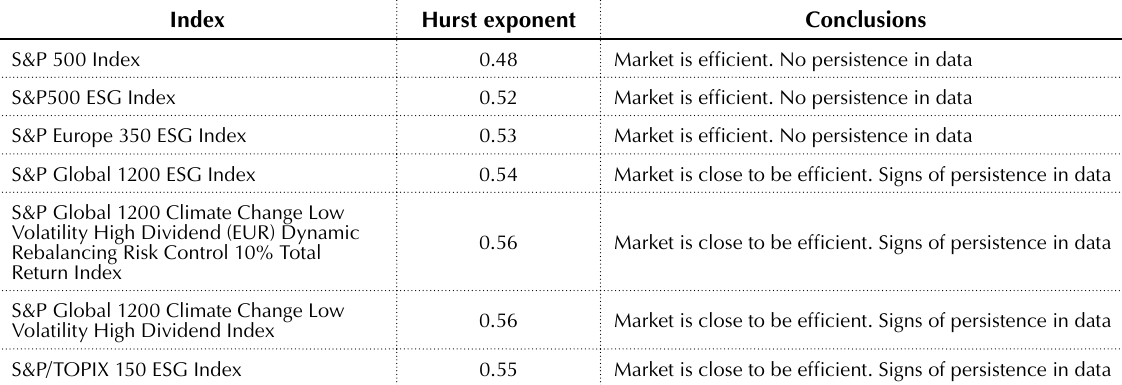
Table 3. Overall results of the Hurst exponent calculations for the S&P500 Environmental & Socially Responsible Index and traditional S&P500 Index